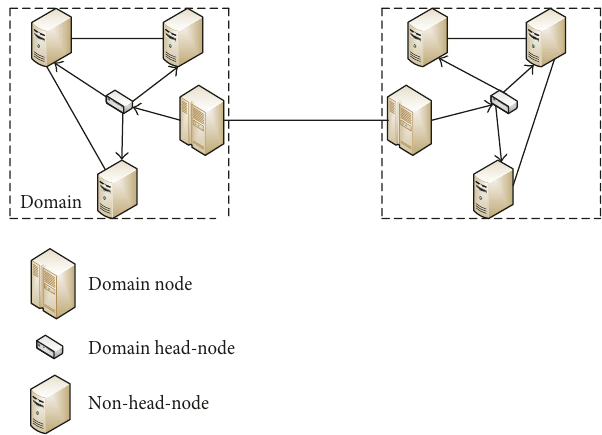
Figure 1: Structure for data